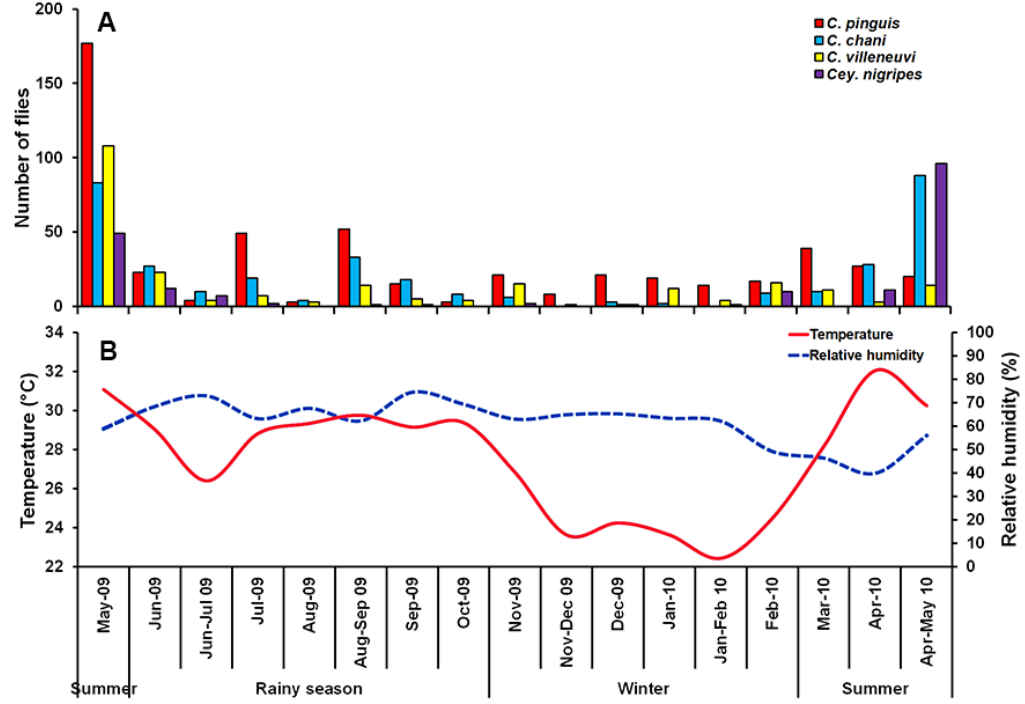
Figure 2. Monthly fluctuations in population density of C. pinguis , C. chani , C. villeneuvi , and Cey. nigripes determined using a reconstructable funnel trap baited with 1-day tainted beef offal in Chiang Mai province, northern Thailand, May 2009 to May 2010 ( A ), and Annual variation of temperature and relative humidity recorded during the fly survey ( B ).